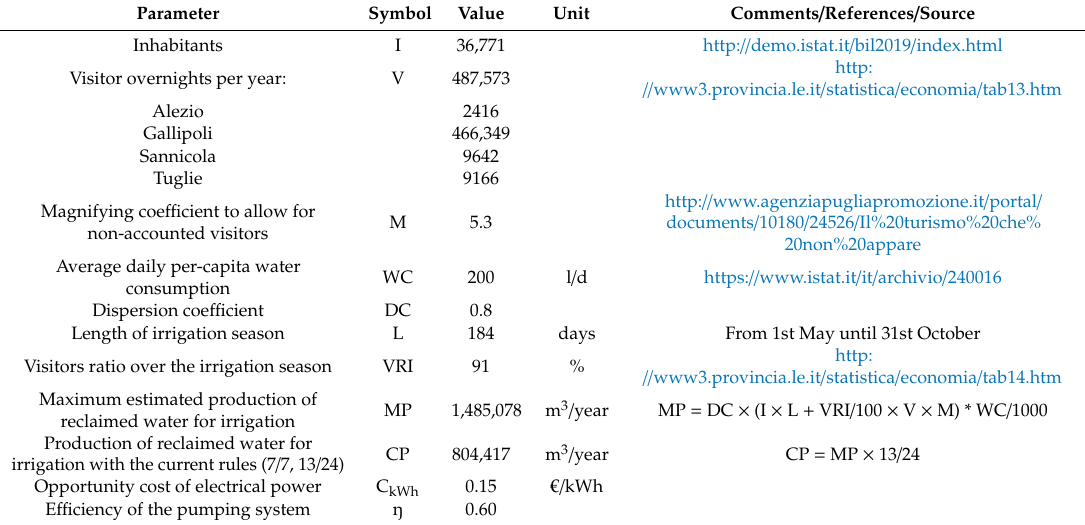
Table 3. Technical parameters used throughout the